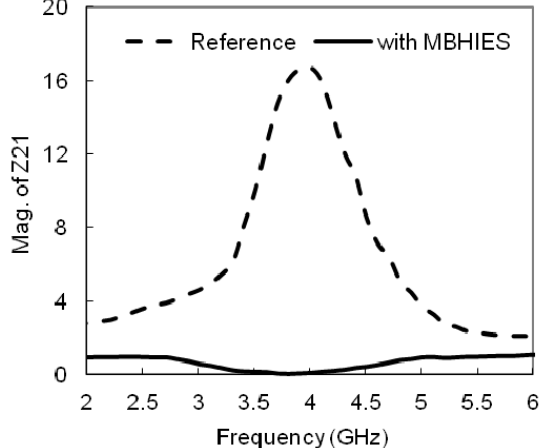
for the proposed HIES design. 21